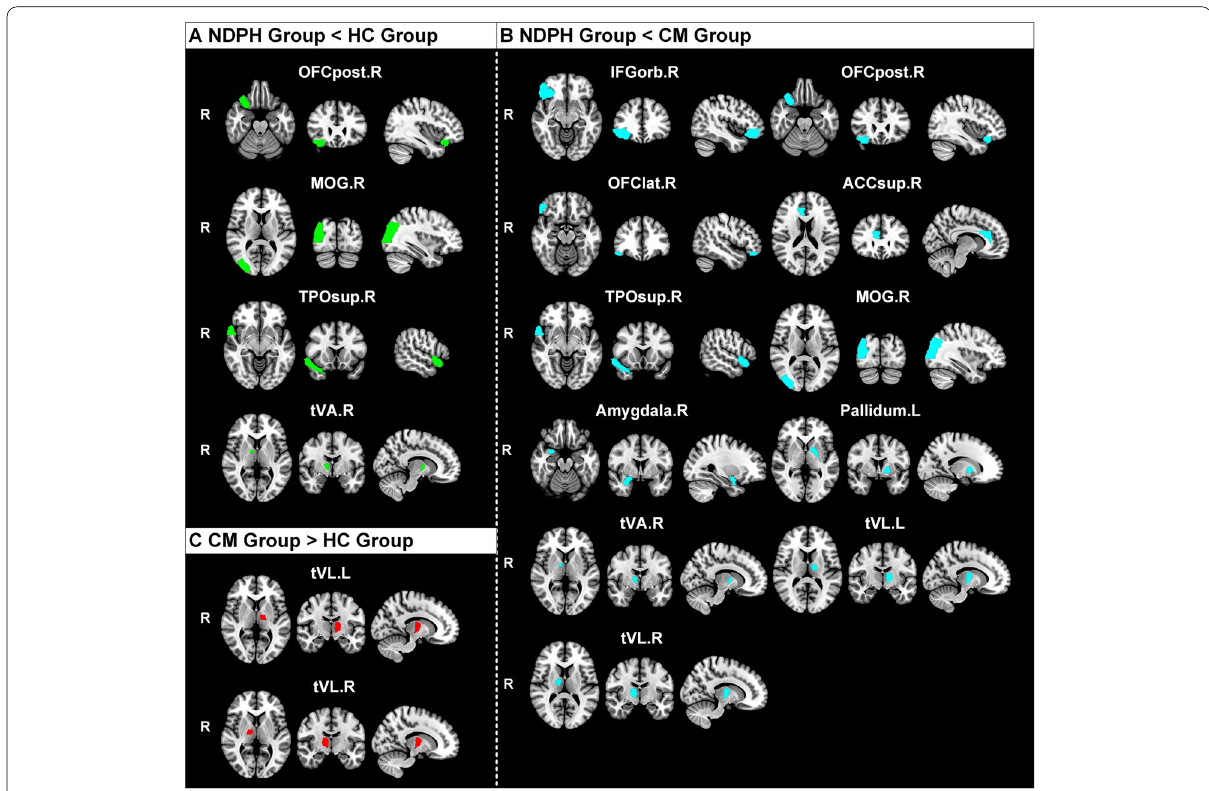
Fig. 4 The visualization of brain regions with significant differences in cerebral perfusion between NDPH and HC groups, CM and HC groups, as well as NDPH and CM groups. The brain regions with decreased cerebral perfusion in NDPH groups were presented compared with HC ( A ) and CM ( B ) groups, respectively. The brain regions with increased cerebral perfusion in CM groups were presented compared with HC groups ( C ). HC healthy control, NDPH new daily persistent headache, CM chronic migraine. IFGorb.R right inferior frontal gyrus pars orbitalis, OFCpost.R right posterior orbital gyrus, OFClat.R right lateral orbital gyrus, ACCsup.R right anterior cingulate cortex, supracallosal gyrus, TPOsup.R right superior temporal gyrus, temporal pole, MOG.R right middle occipital gyrus, Amygdala.R right amygdala, Pallidum.L left pallidum, tVA.R right thalamus, ventral